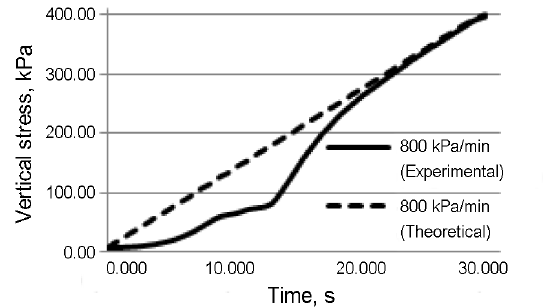
Fig. 8. Vertical stress ramp velocity versus vertical stress loa- ding